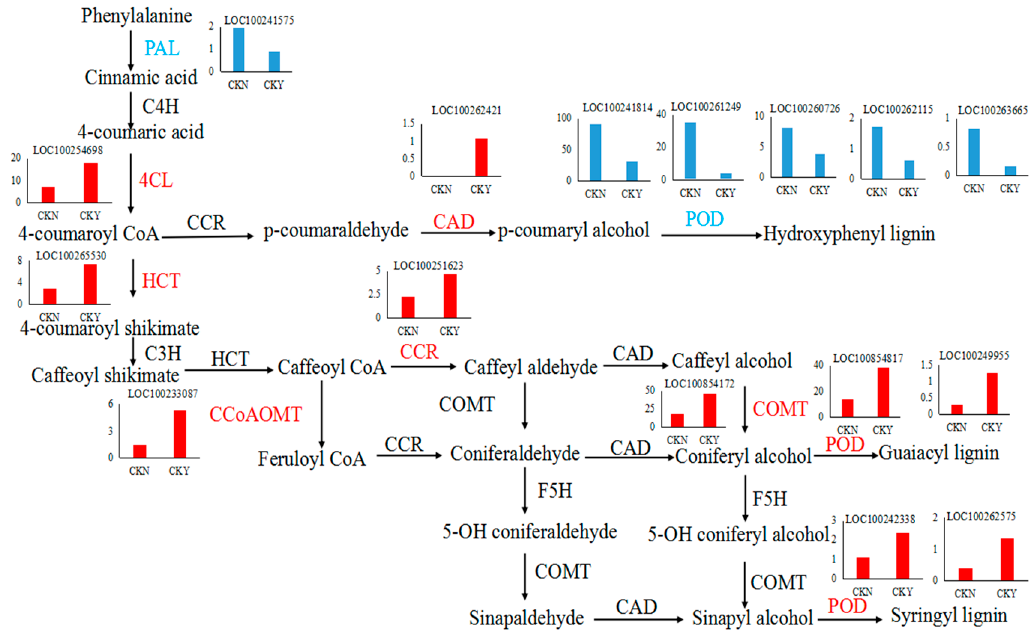
Figure 9. Lignin biosynthesis pathway. Each histogram displays the expression levels of each particular gene (FPKM value). The charts in blue and red represent the down-regulated and up-regulated structural genes, respectively. Phenylalanine ammonia-lyase, PAL , cinnamic acid 4-hydroxylase, C4H , 4 coumarate CoA ligase, 4CL , cinnamoyl-CoA reductase, CCR , cinnamyl alcohol dehydrogenase, CAD , peroxidase, POD , shikimate O -hydroxycinnamoyl transferase, HCT , coumarate-3-hydroxylase, C3H , caffeoyl-CoA O -methyltransferase, CCoAOMT , caffeic acid 3- O -methyltransferase, COMT , ferulic acid-5-hydroxylase, F5H , non-russet, CKN, russet, CKY.